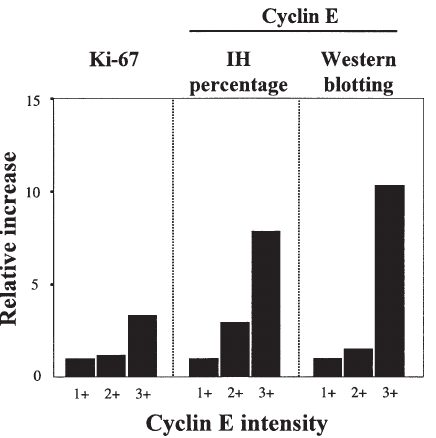
Fig. 4. Mean Ki-67 and cyclin E quantifications according to immunohistochemical staining intensities (1 + to 3 + ) expressed relative to tumours with 1 + (low) intensity which was assigned a value of one. IH: